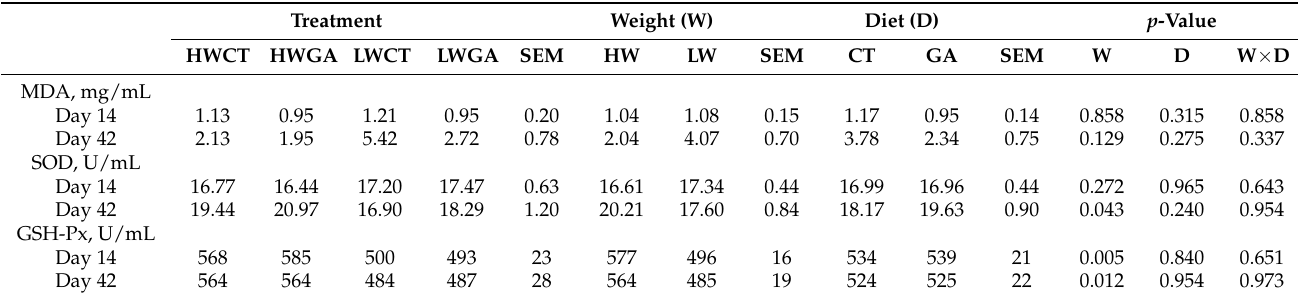
Table 3. Effect of dietary GA on plasma antioxidant status of high and low weaning weight piglets. Treatment Weight (W) Diet (D) p